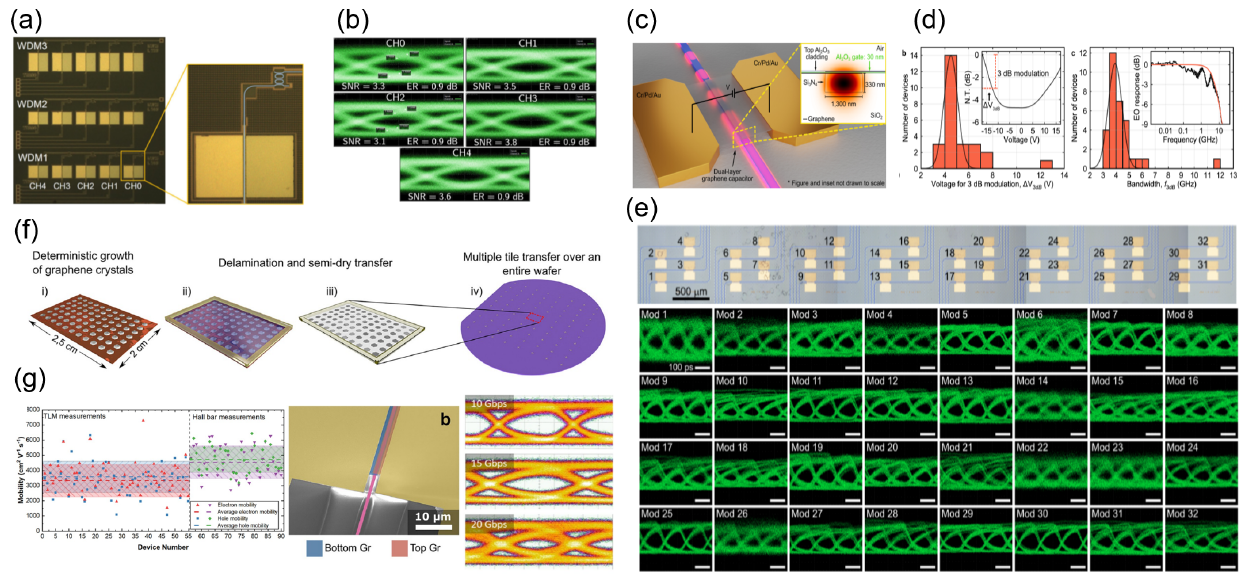
Figure 7. Arrayed graphene − based EO modulators with uniform performance. ( a , b ) Top-view microscope image showing three WDM transmitters, each based on five SLG-Si EA modulators and five MRRs-based multiplexers. Eye diagrams measured at 25 Gbit/s across the five channels [36]. Reproduced from Ref. [36] with permission. ( c – e ) Schematic of the DLG (graphen-Al 2 O 3 -graphene)- based electro-absorption modulators. Inset: device cross-section. Histograms of the measured voltage changes required for 3 dB modulation from maximum transmission and EO bandwidths. Measured eye diagrams of 32 graphene modulators at 7 Gbps [42]. Reproduced from Ref. [42] with permission. ( f – g ) Multiple tile-stamping steps for wafer-scale graphene transfer. Statistics of e and h mobility in the SLG transferred from TLM and Hall measurements using the proposed method. SEM image of DLG EA modulators showing the overlap of the two SLG above the Si 3 N 4 waveguide. Eye diagrams at 10, 15, and 20 Gbps for the DLG EA modulators [33]. Reproduced from Ref. [33] with